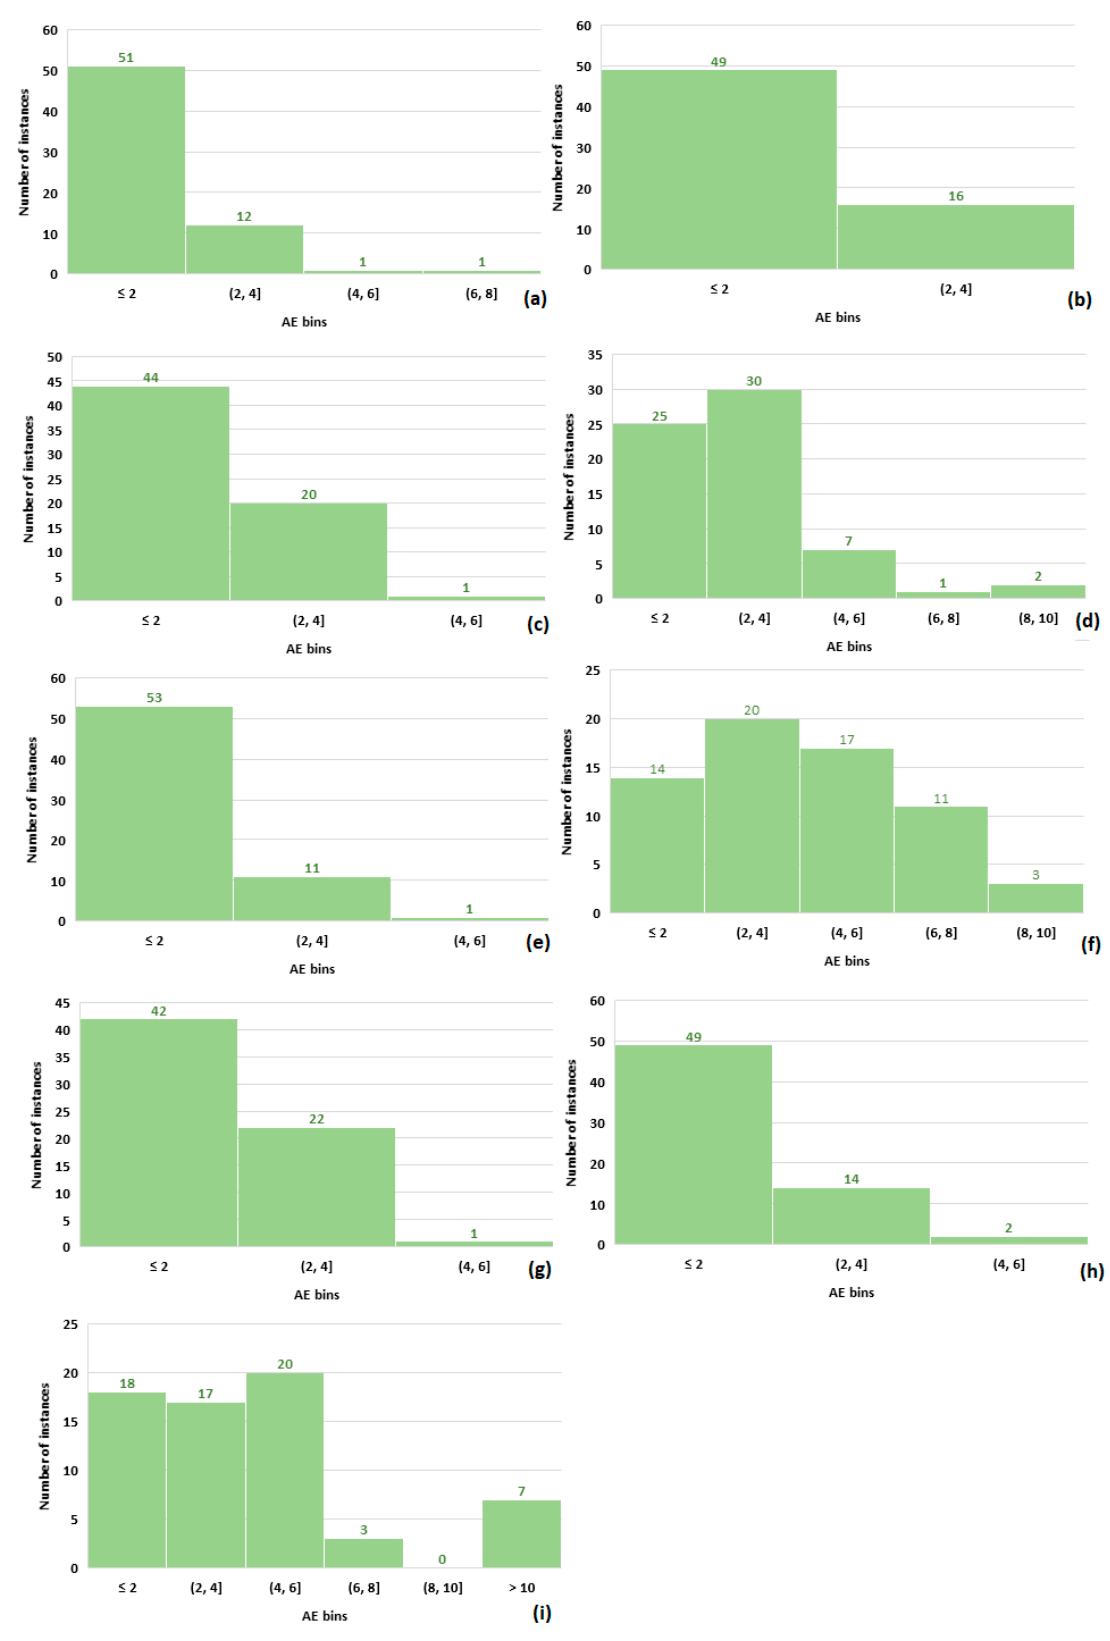
Figure 11. AE distribution for ( a ) ENN, ( b ) FFNN, ( c ) GMDH, ( d ) GRNN, ( e ) LSTM-ENN, ( f ) RBF, ( g ) RVM, ( h ) SVR, and ( i ) MRM for Test Case #2.